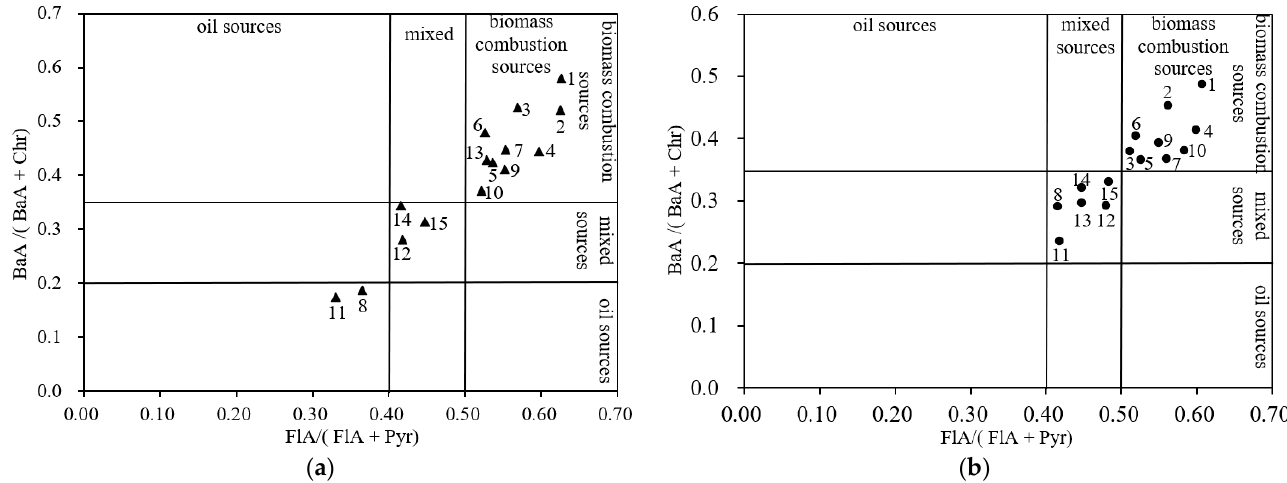
Figure 5. ( a ) Sources of PAHs in groundwater; ( b ) Sources of PAHs in sediments.